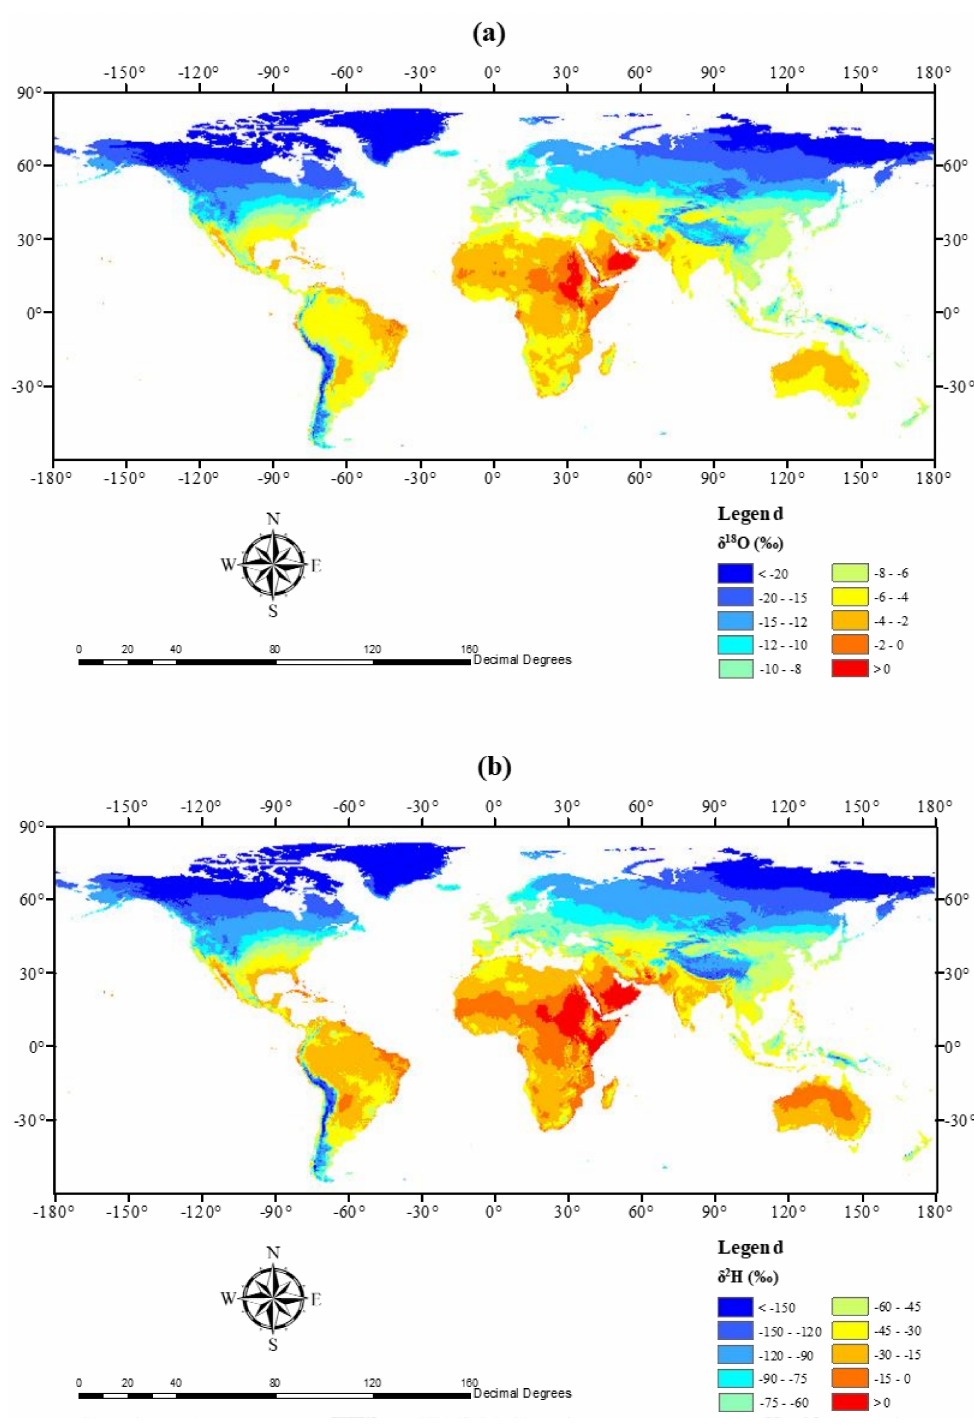
Figure 9. Global distribution of ( a ) δ 18 O and ( b ) δ 2 H in precipitation. The values are overlaid on a background based on Regionalized Climatic Water Isotope Prediction (RCWIP)